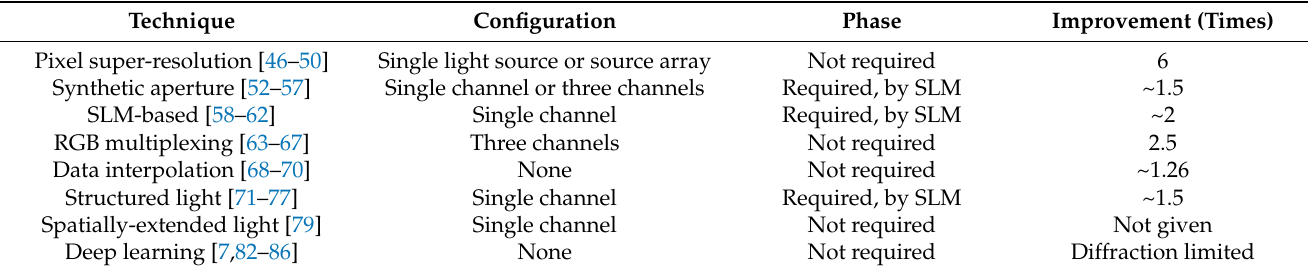
Table 1. Characteristics of various resolution enhancement